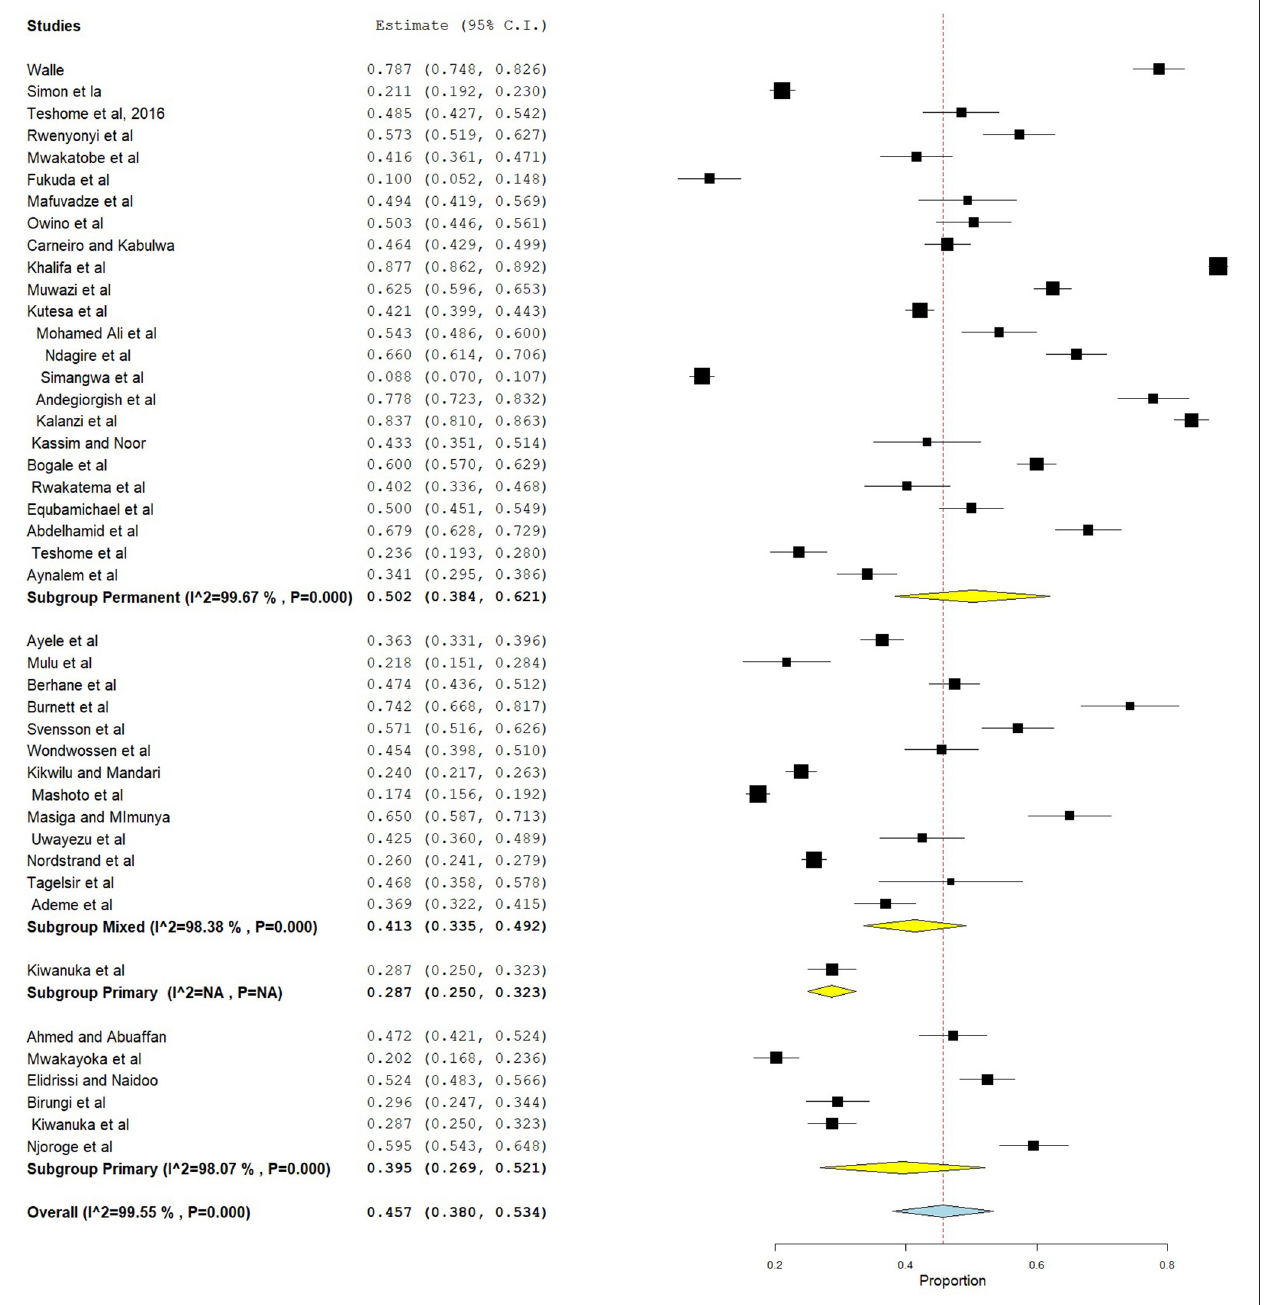
FIGURE 5 | Subgroup analysis on prevalence of dental caries based on dentition